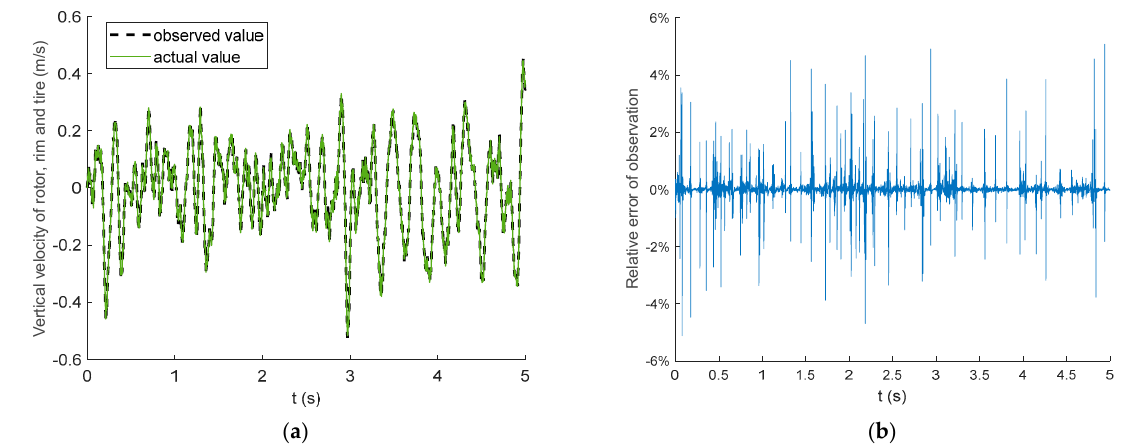
Figure 9. Observed results of vertical velocity of rotor, rim and tire. ( a ) Comparison of observed and actual values. ( b ) Relative error between observed and actual values.